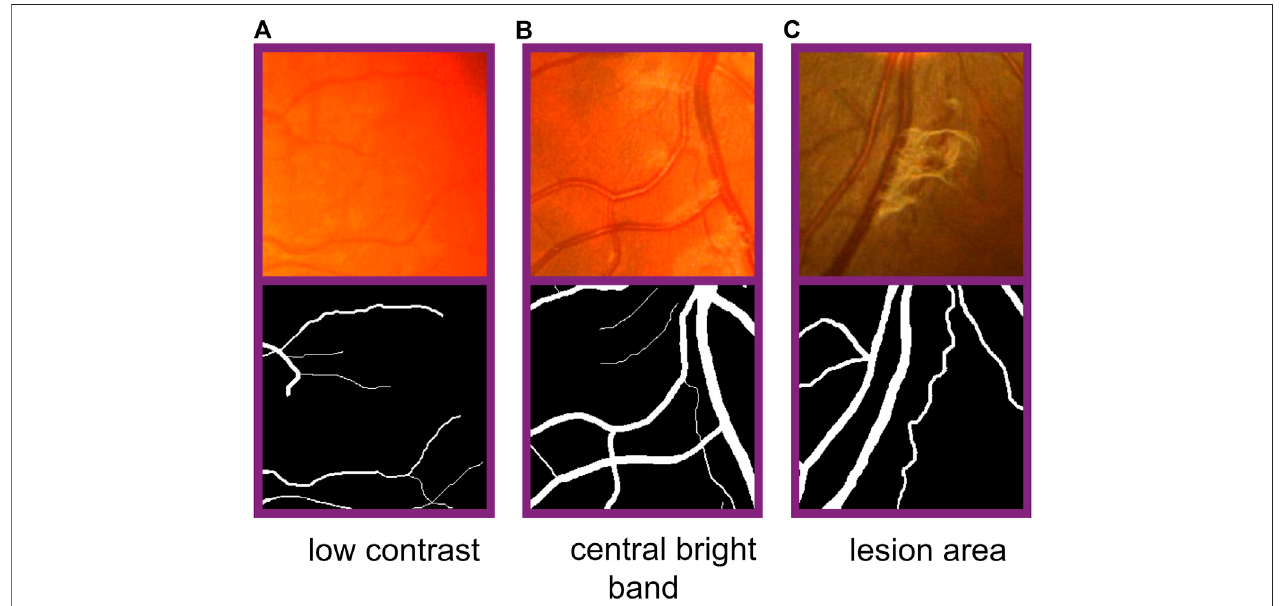
FIGURE1| Dif fi cultiesinfundusimagesegmentationtask. Fromthelefttoright: lowcontrastbetweenbloodvesselsandbackground,central brightbandinblood vessels, and lesion area around vessels. From the top to bottom: part of original images and corresponding labels.